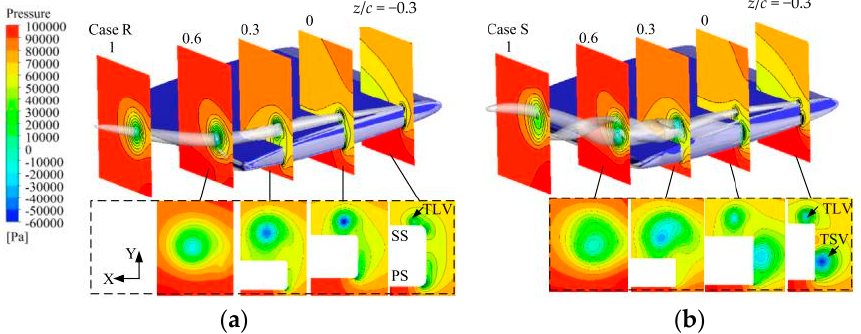
Figure 32. Pressure distribution on different chord sections: ( a ) round-tip foil; ( b ) sharp-tip foil [78]. TSV: tip-separation vortex.